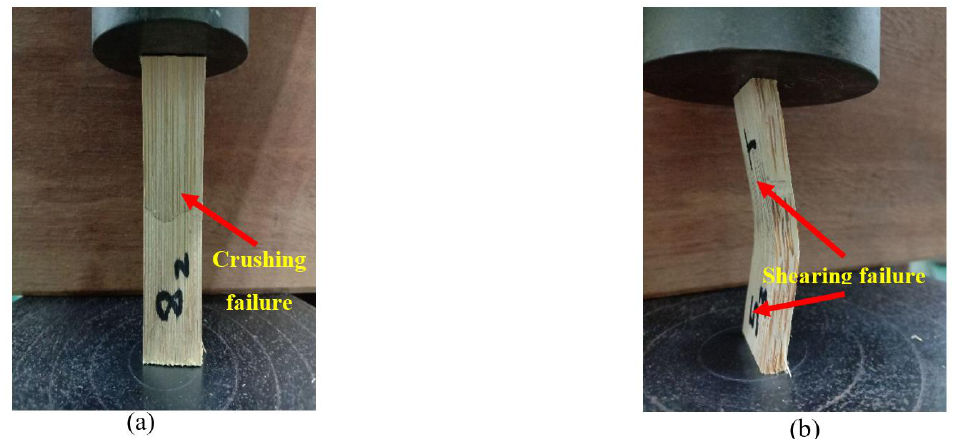
Figure 10. Failure mode of strips from four bamboo species for compression parallel to the grain: ( a ) failure due to crushing, ( b ) shearing failure in the bamboo strip.